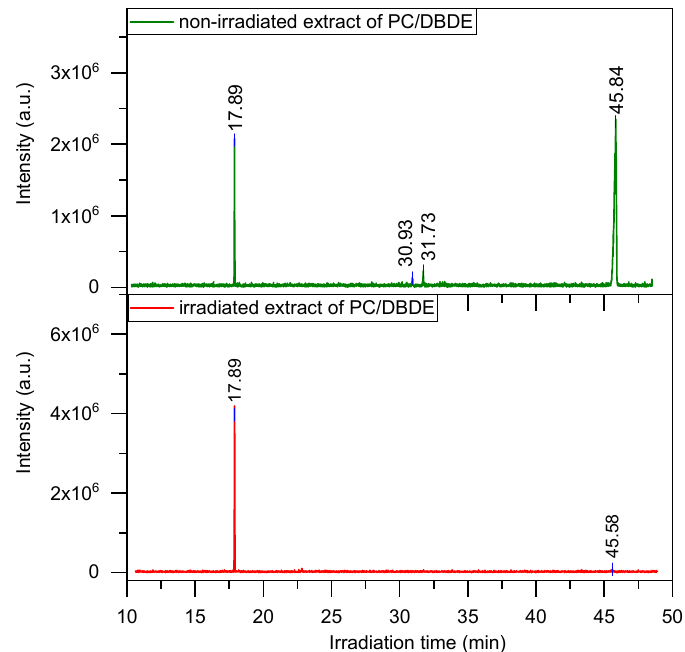
Figure 4. GC chromatograms of extracted solutions from 90 wt-% PC/10 wt-% DBDE films before and after irradiation for 10 min under reduced pressure.